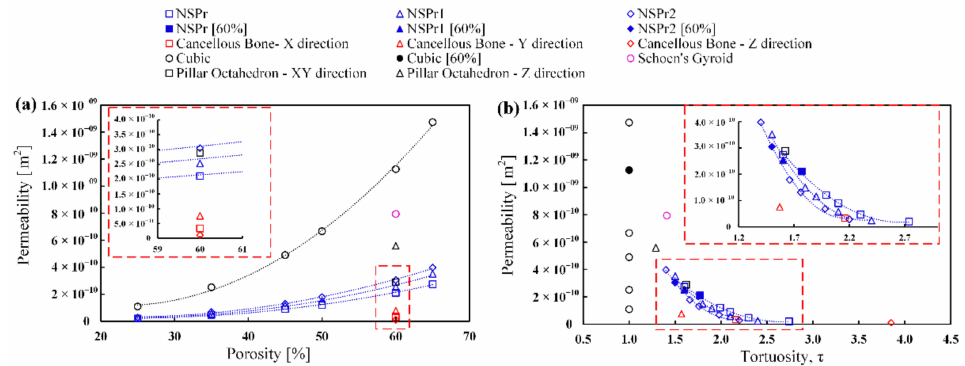
Figure 6. Relationship between permeability and: ( a ) porosity scaffold; ( b ) tortuosity scaffold.